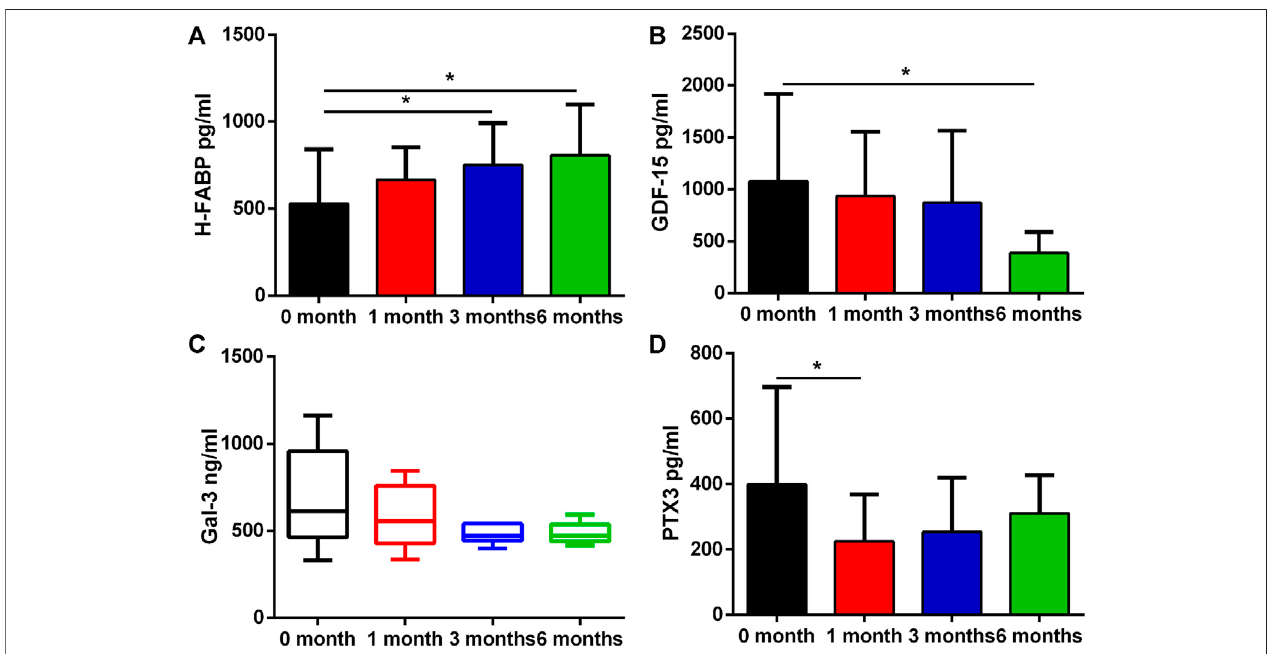
FIGURE2| Proteinsthathaddifferentialplasmalevelsbetweenbaselineand1,3and6months.Edgesofboxesdenote25thand75thpercentiles,linesaremedian concentrations, and error bars are minimum and maximum concentrations. (A) NT-pro BNP: N-terminal pro – B-type natriuretic peptide; (B) D-dimer; (C) CK: creatine kinase; (D) CK-MB: creatine kinase-MB.